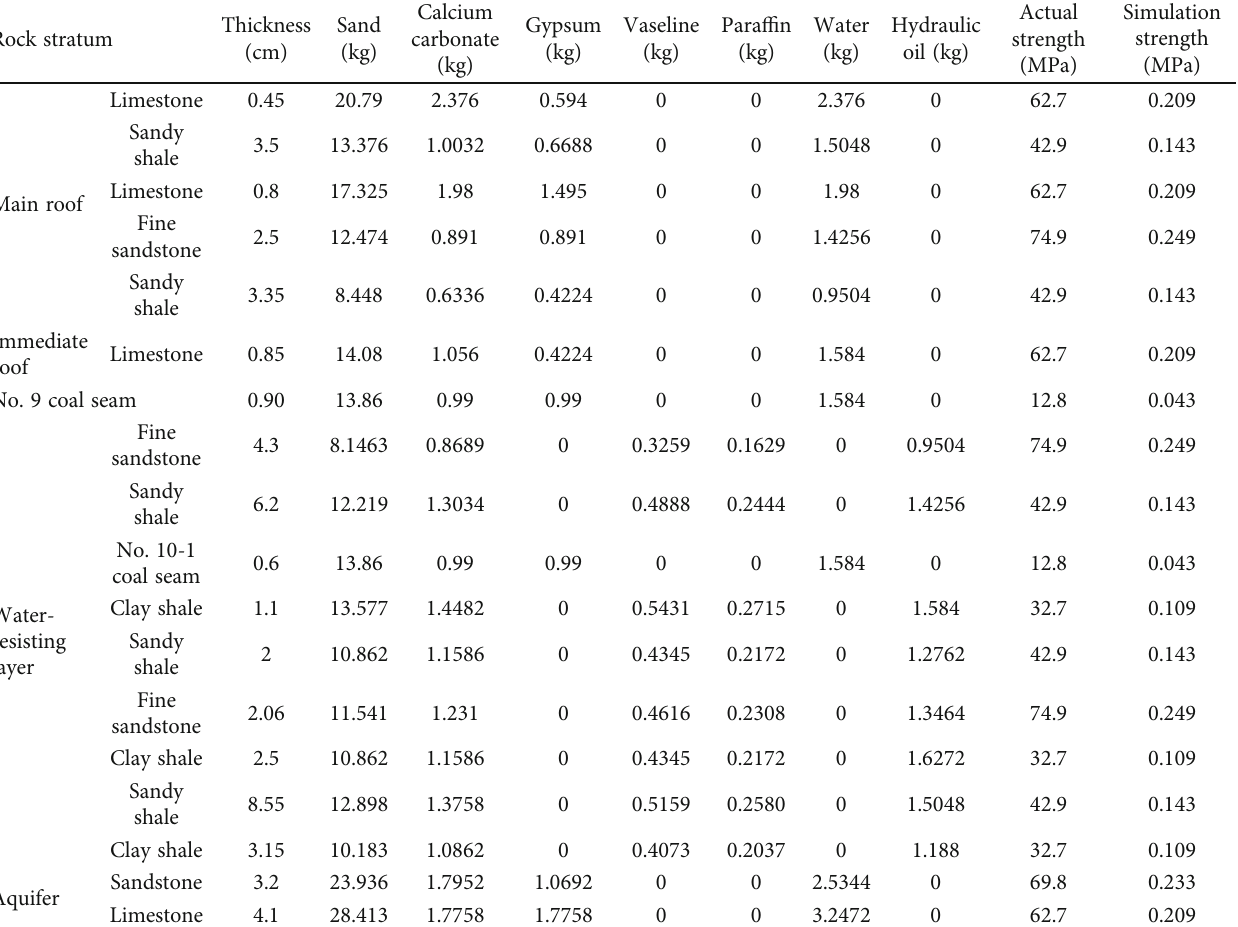
Table 1: Physical and mechanical parameters of the strata used in the